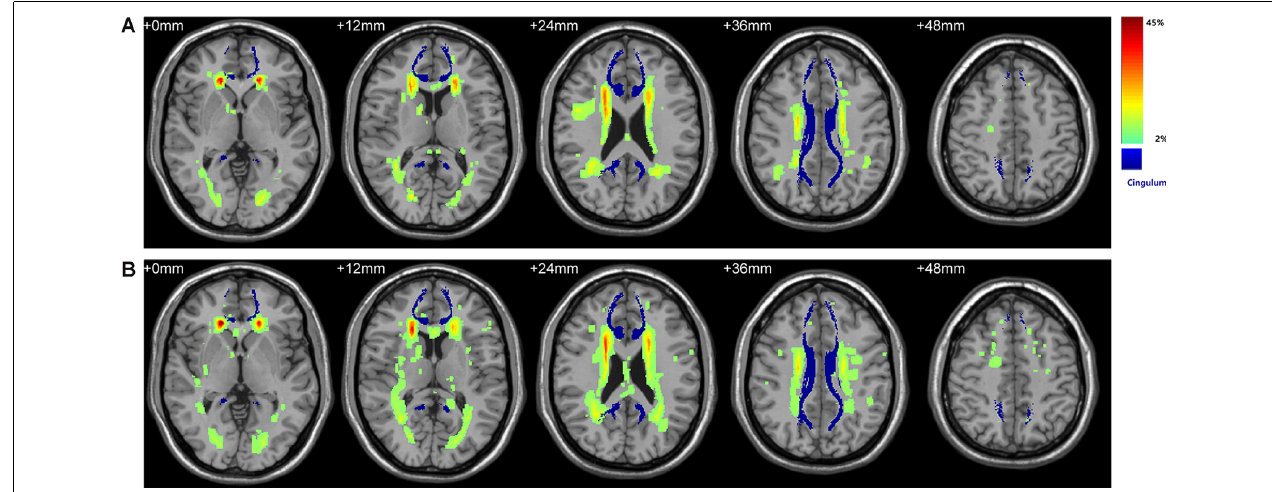
FIGURE 1 | Spatial distribution of WMH and its overlay with bilateral cingulum. (A) WMH distribution in the control group. (B) WMH distribution in the Type 2 diabetes (T2DM) group. Color denotes the frequency of WMH at each anatomical location, serving as a measure of inter-subject variability in each group. The WHM distribution has a predilection for periventricular and deep WM areas, especially in frontal periventricular regions (red). Bilateral CB shown in blue was derived from the fiber template HCP1021-1mm (https://pitt.app.box.com/v/HCP1021-1mm). WMH, white matter hyperintensity; WM, white matter; CB, cingulum bundle.